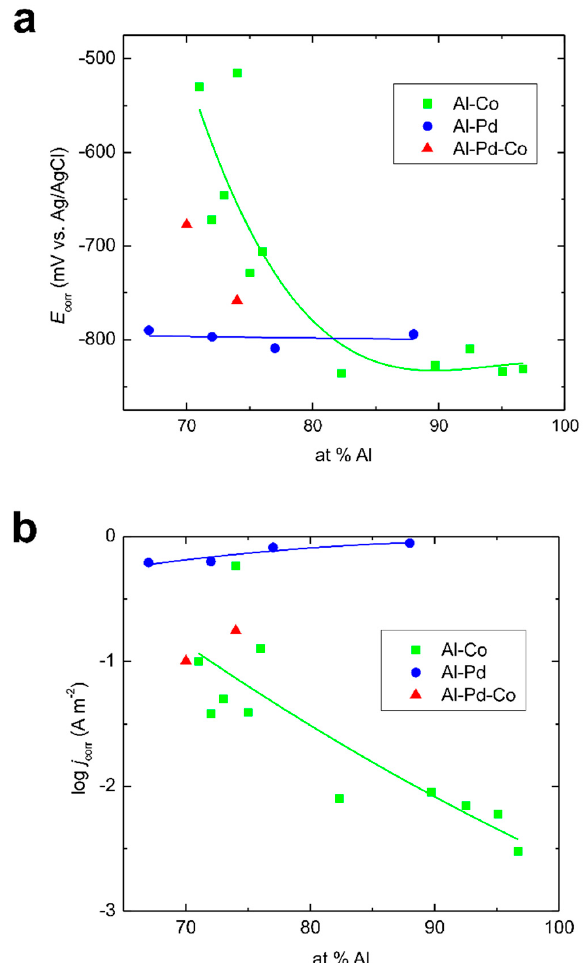
Figure 11. Corrosion potentials ( a ) and corrosion current densities ( b ) of as-solidified Al–Co, Al–Pd, and Al–Co–Pd alloys. Lines are a guide to the eyes only. For the color interpretation of this figure, the reader is referred to the web version of this article.